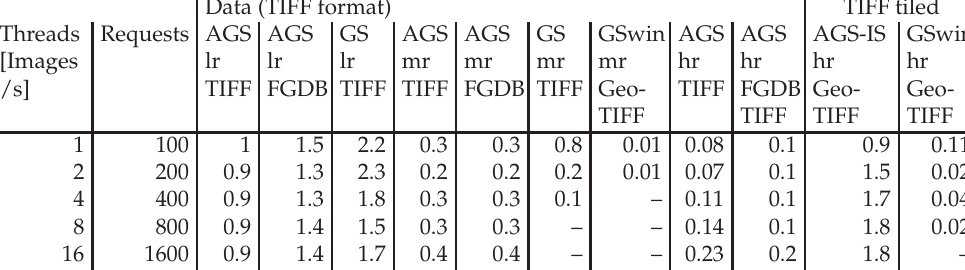
Table 7: WCS Geoserver (GS) and ArcGIS Server (AGS) tests results. An ArcGIS Server Image Service (IS) has also been tested. Tests have been executed on Linux and Windows